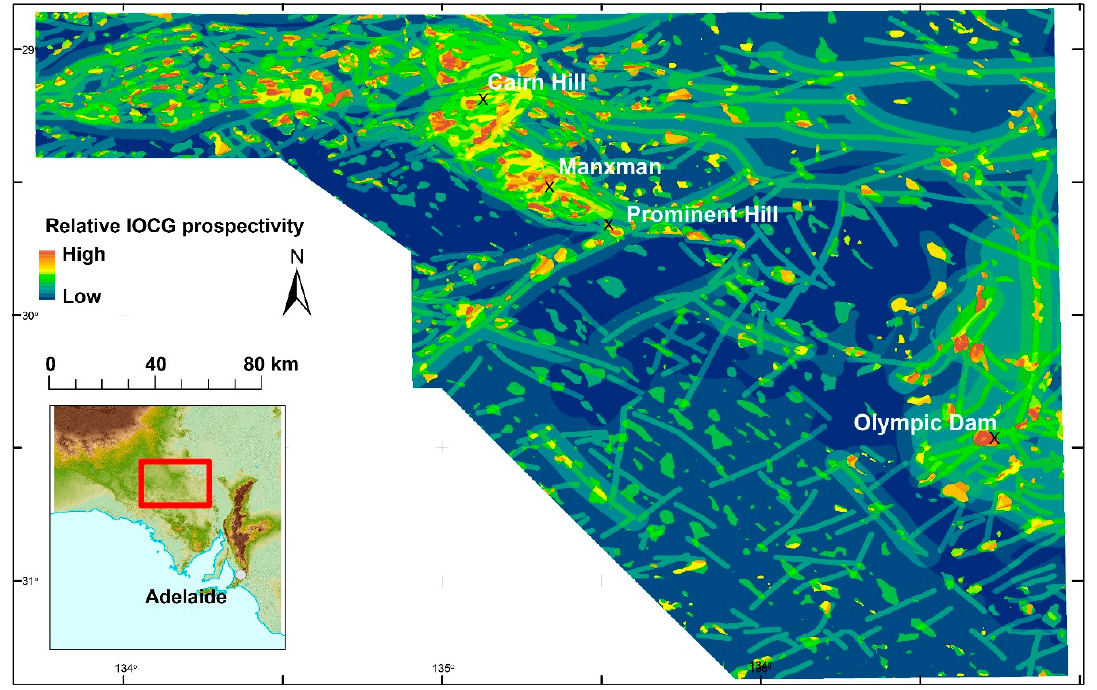
Figure 15. Results of mineral prospect mapping in the north-eastern Olympic Cu-Au Province in the vicinity of Olympic Dam and Prominent Hill of Wise and Katona [149].